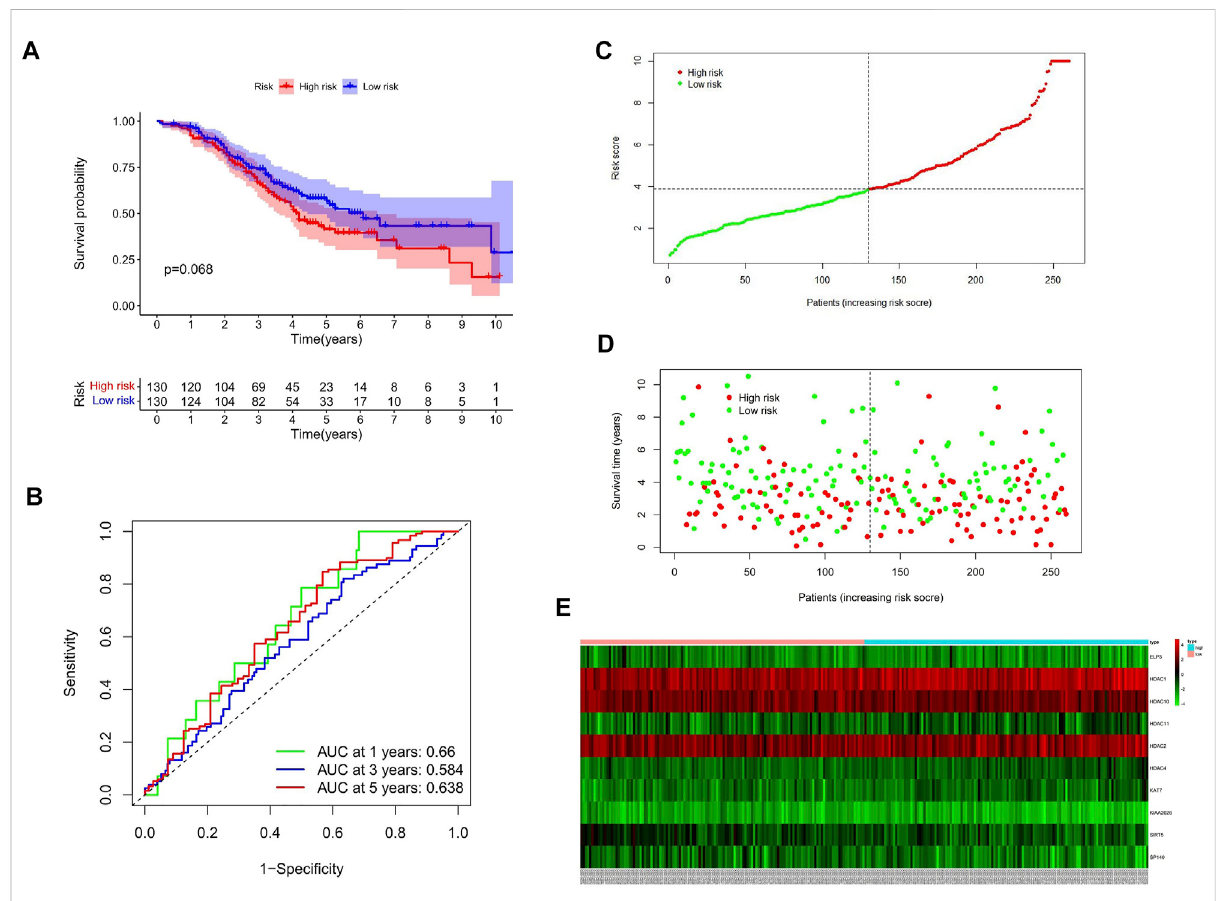
FIGURE 4 Validation of HAM signature in the GEO cohort. (A) Kaplan – Meier curves to compare OS of high-risk and low-risk groups in the validation cohort. (B) Time-dependentROCcurvespredicted1-,3-,and5-yearprognosticperformanceinthevalidationcohort. (C) Riskscoredistribution. (D) Individual status of survival. (E) Heat map of the differentially expressed genes between high and low